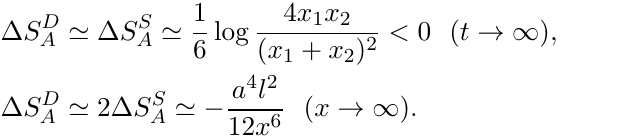
((cid:1) S S ( x = b ) + (cid:1) S S ( x = (cid:0) b ) ) under the time evolutions of EE in A (cid:0) A A